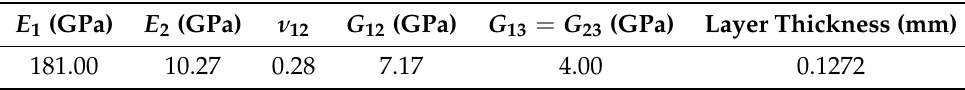
Table 1. Material Properties [29,35].